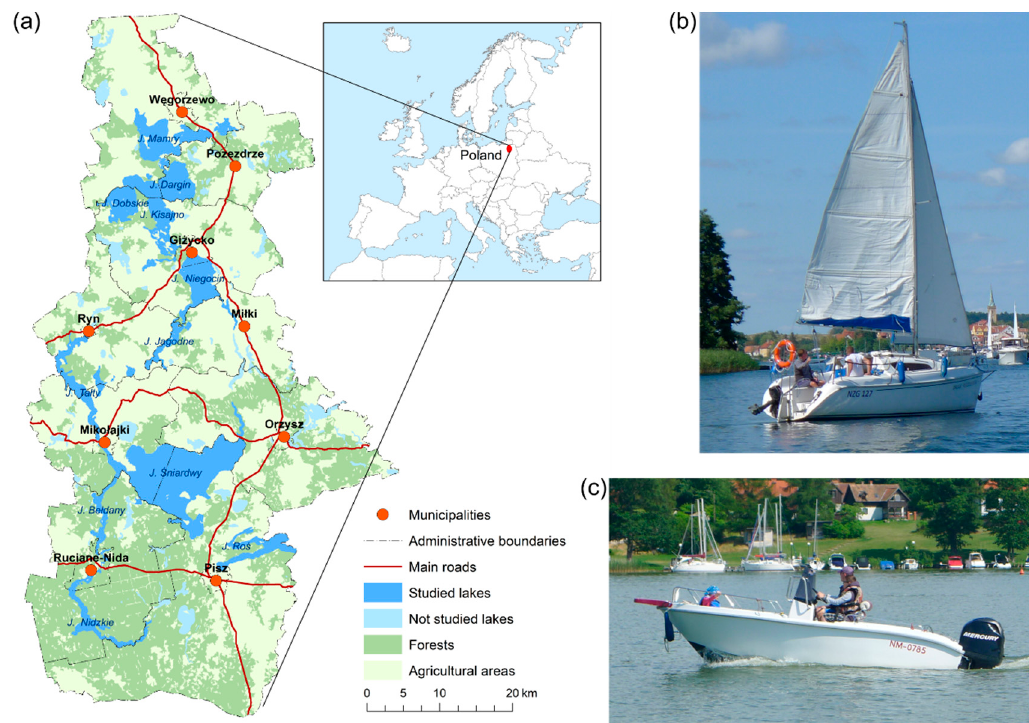
Figure 1. The study area ( a ): typical recreational sailing boat found in the area ( b ) and typical recre- ational motorboat found in the area ( c ).